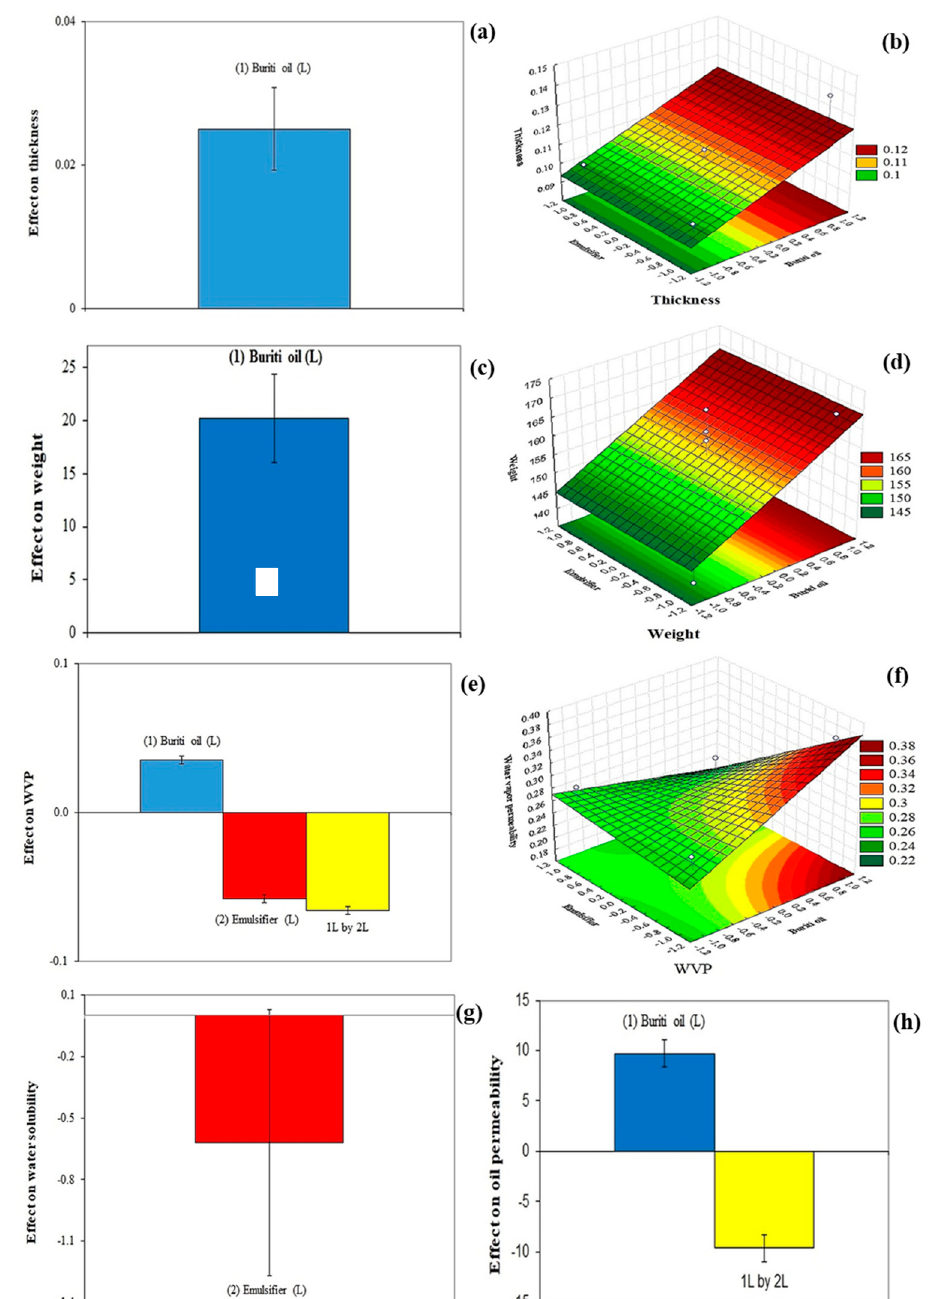
Figure 1. Effect of buriti oil and emulsifier (Tween 20) on the thickness ( a ), weight ( c ), water vapor permeability (WVP) ( e ), water solubility ( g ), and oil permeability ( h ) of the cassava-starch-based films. Response surfaces show the influence of buriti oil and emulsifier on the thickness ( b ), weight ( d ), and WVP ( f ) of films.